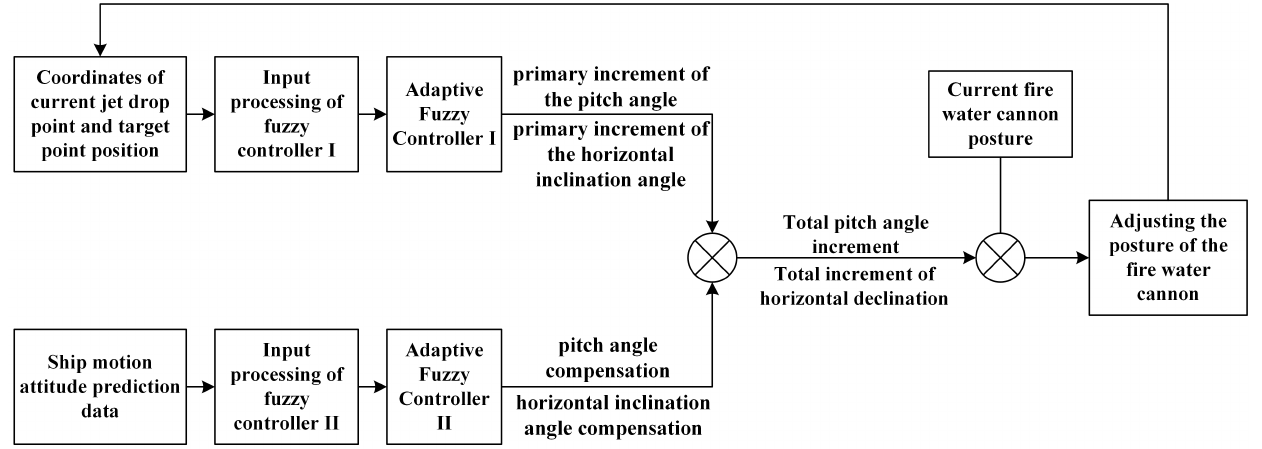
Figure 2. Block diagram of the water cannon control system of the unmanned fireboat considering wind and ship motion disturbances.